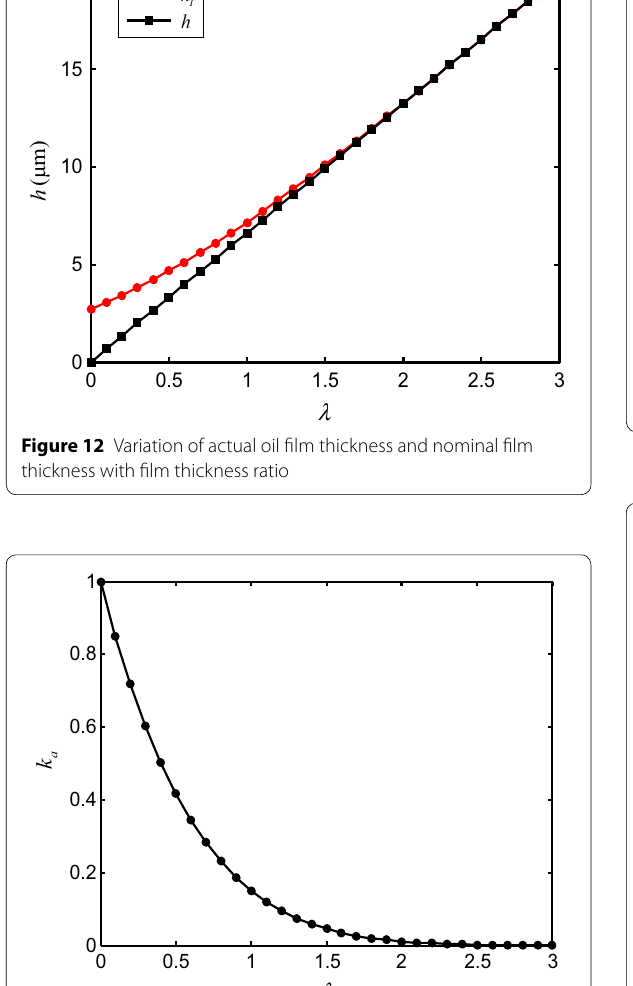
Figure 15 Variation of asperity friction torque with film thickness